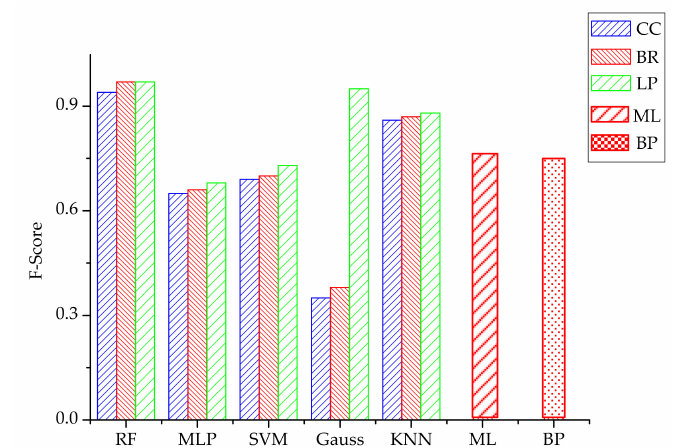
Figure 11. The F-Score of each multi-label classification algorithm.